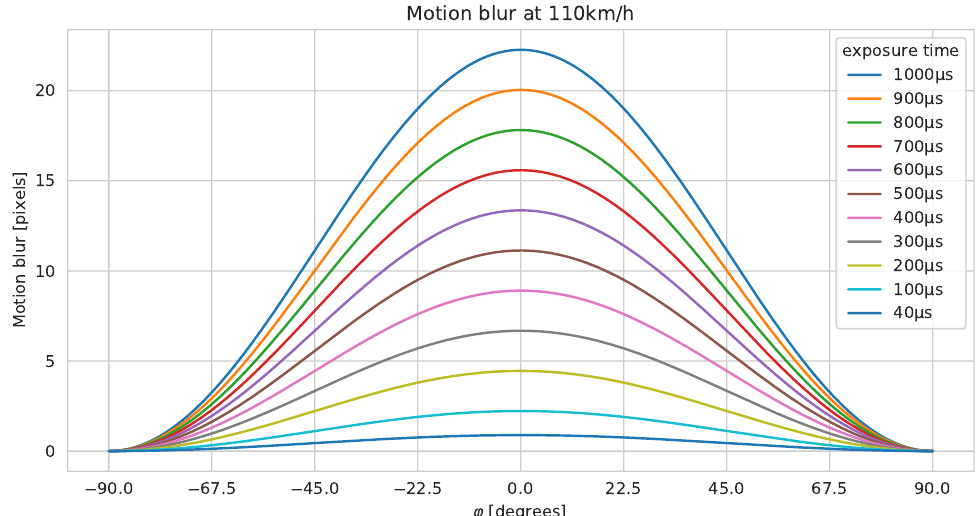
Figure 3. Motion blur at different orientations of center pixel in image when driving 110 km/h with a Sony IMX226 with a lens that ensures a 46° horizontal field of